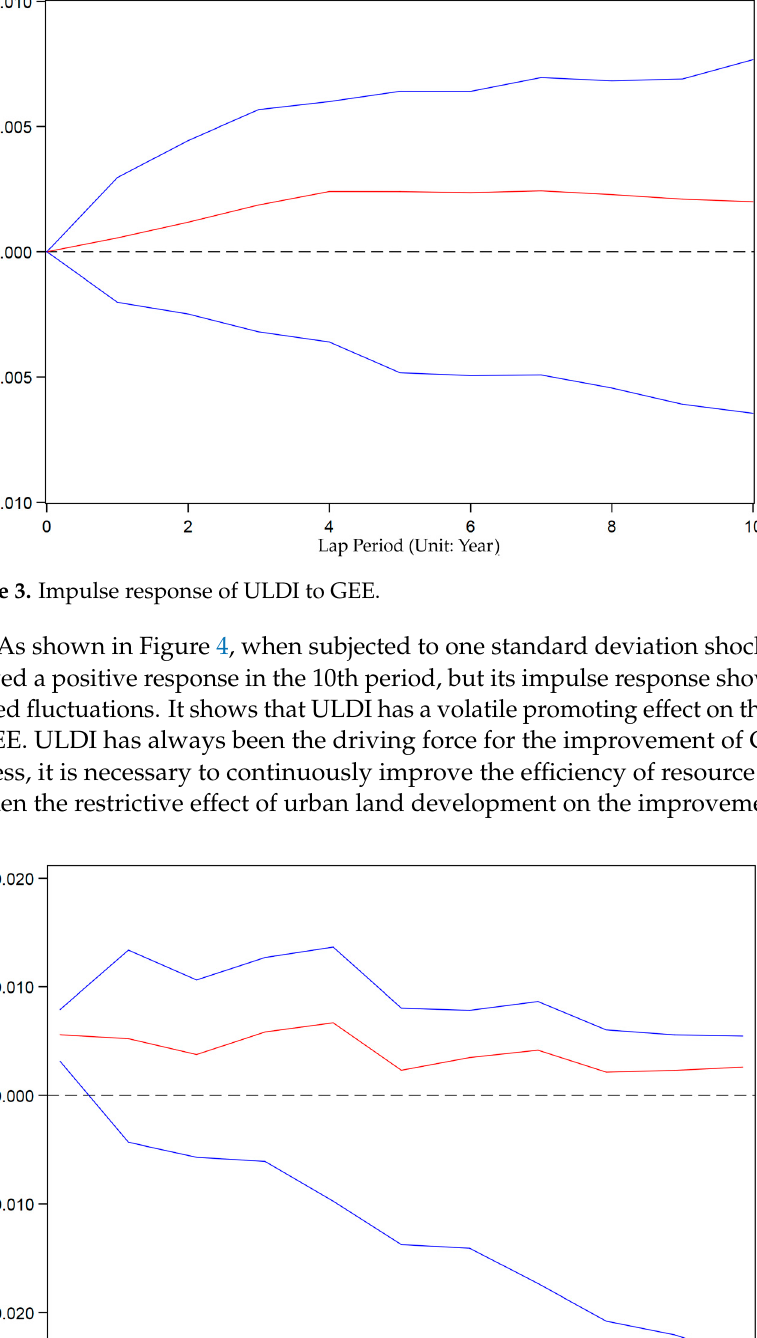
Figure 2. Impulse response of ULDI to ULDI.